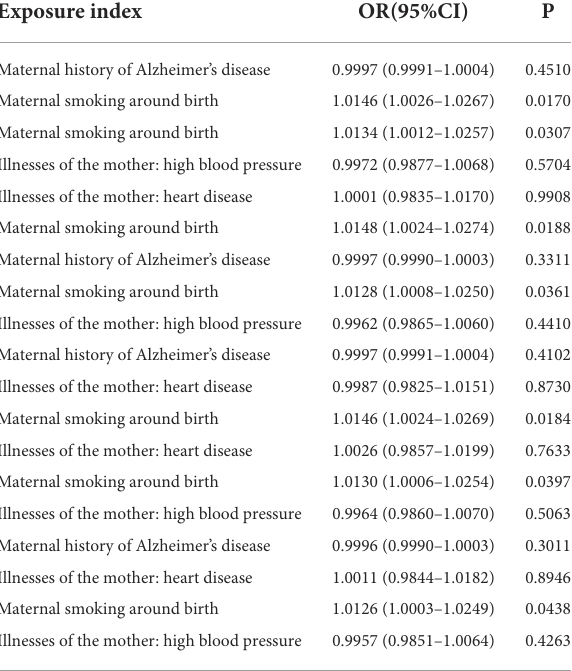
TABLE 4 Multivariable Mendelian randomization results of maternal smoking around birth on childhood